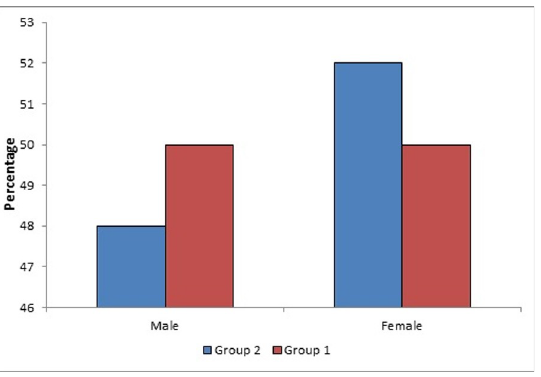
Fig 3. Gender distribution among the studied Mediterranean hemopathic syndromes patients’ groups.